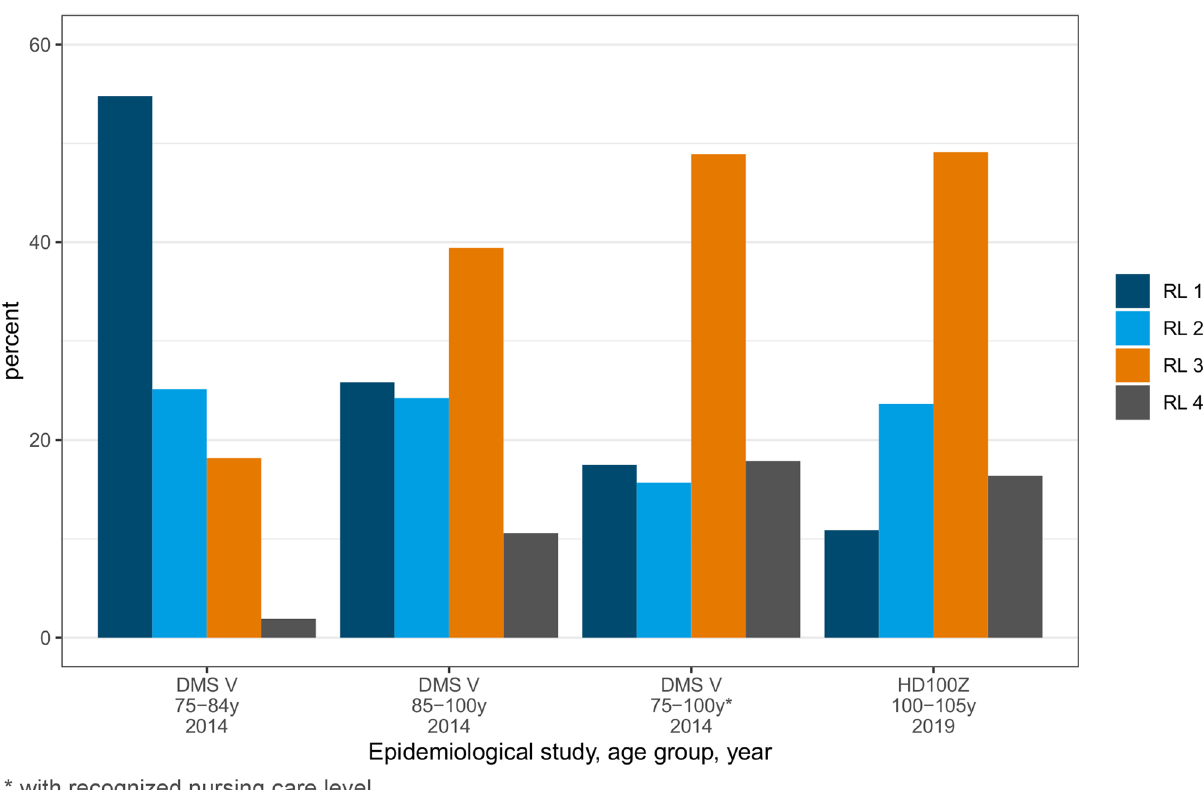
Figure 3. Resilience level in older adults in Germany aged 75–100 years old and in the centenarian population of this